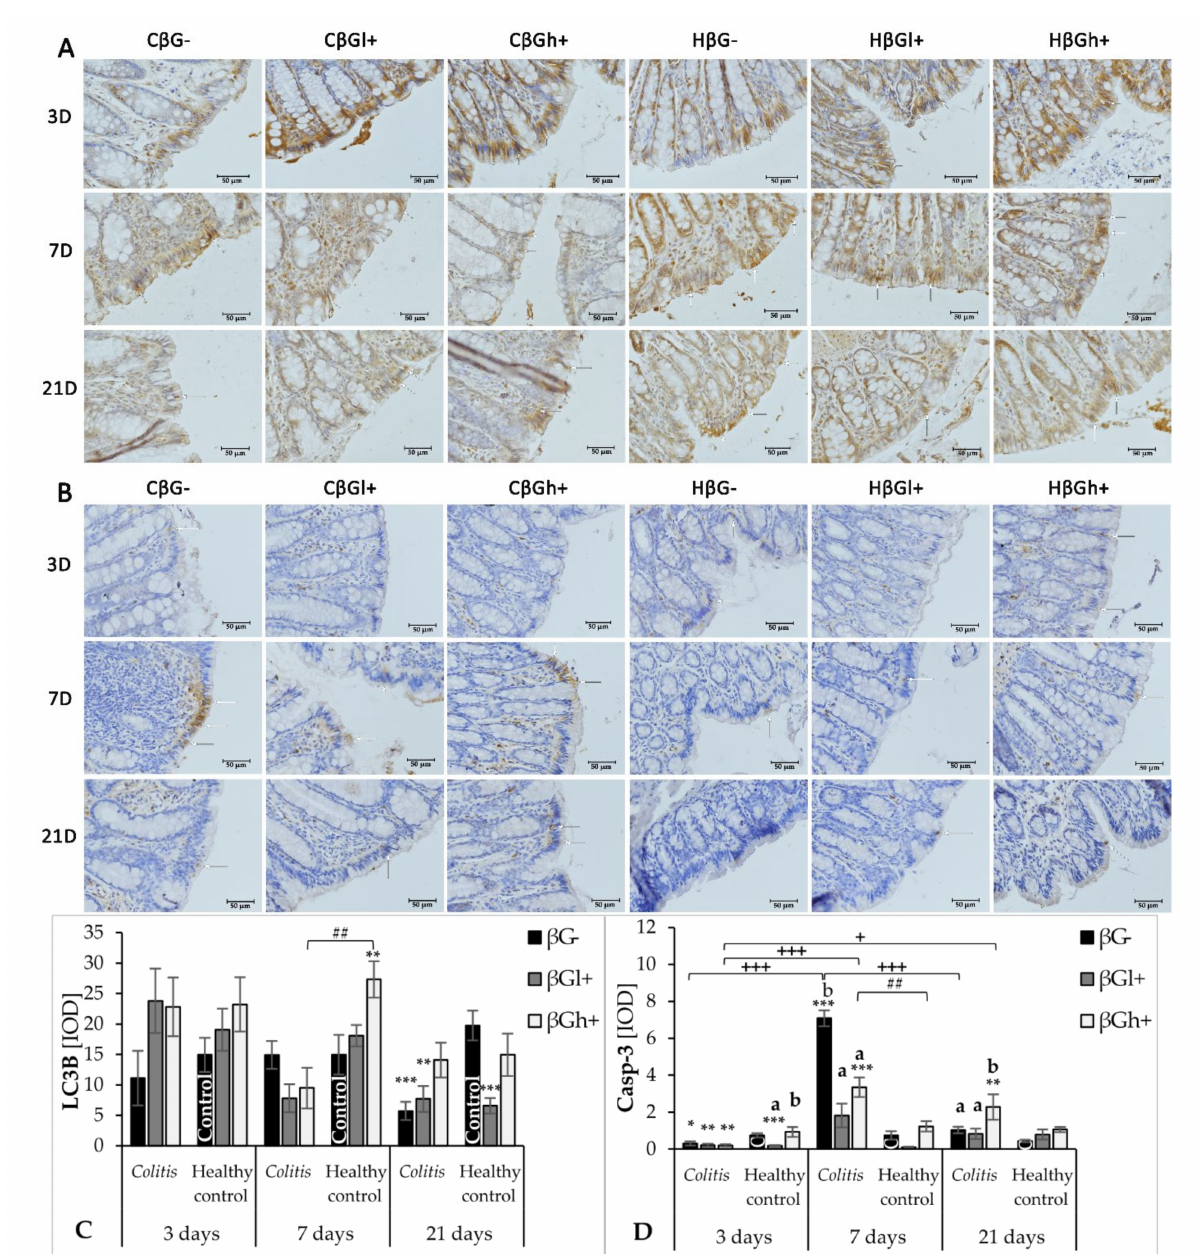
Figure 5. Expression of autophagy and apoptosis markers in the colonocytes: results of the immunohistochemical analysis. White arrows indicate colonocytes with high expression of the LC3B protein ( A ) and Caspase-3 protein ( B ) (brown precipitate). ( A , B )—Light micrographs imaged under the NIKON Eclipse Ti2 microscope ( × 40 magnification). ( C , D )— Changes in the expression of autophagy and apoptosis markers (LC3B and Caspase-3 (Casp-3), respectively) presented (mean ± SE) as integrated optical density (IOD) . Autophagy-related protein LC3B antigen is represented by a brown precipitate in the colonocytes in ( A ). Apoptosis-related protein Casp-3 antigen is represented by a brown precipitate in the colonocytes in ( B ). * Significantly different from the control group (control β G − ) at the same time point according to the Dunnett post hoc test (* p < 0.05, ** p < 0.01, *** p < 0.001). # Significantly different between the colitis and control groups at the same time point and the same feed according to the Tukey post hoc test ( ## p < 0.01). + Significantly different from the same subgroups at another time point according to the Tukey post hoc test ( + p < 0.05, +++ p <0.001). a,b Different letters denote significant differences in the colitis /control group at the same time point according to the Tukey post hoc test ( p <